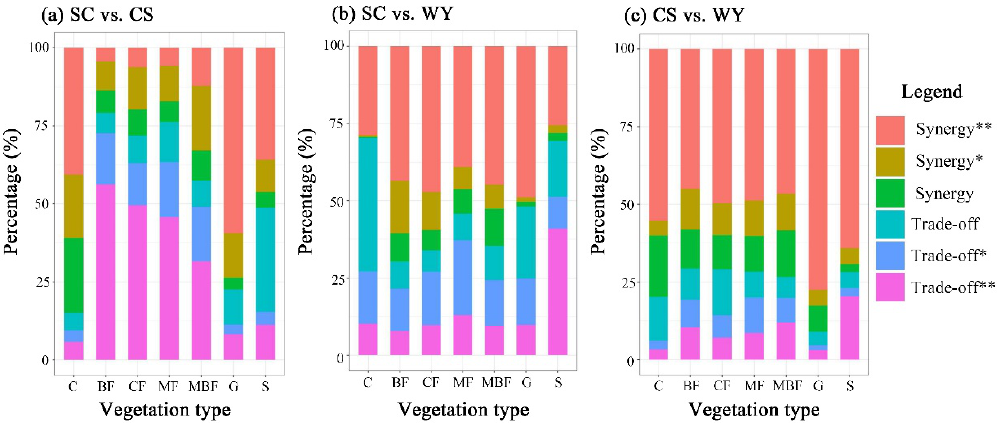
Figure 7. Trade-offs and synergistic of ecosystem services among different vegetation types. C, cropland; BF, broad-leaved forests; CF, coniferous forests; MF, mixed forests; MBF, Moso bamboo forests; G, grass; S, shrub; ( a ) soil conservation and water yield; ( b ) soil conservation and carbon sequestration; ( c ) carbon sequestration and water yield. *: 0.05 < p < 0.10; **: 0.01 < p < 0.05.